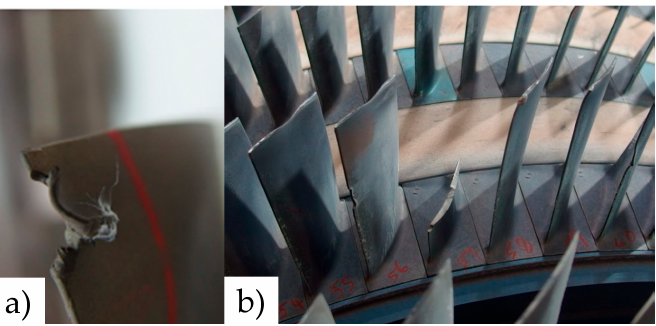
Figure 7. Possible damages due to impacts [52]. ( a ) Impact with a sharp object; ( b ) Broken HPC